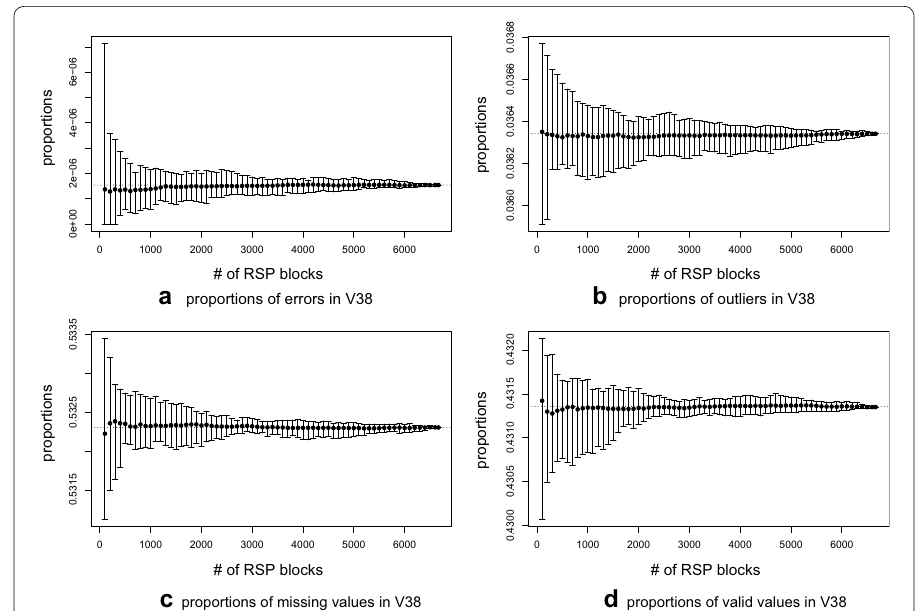
Fig. 11 Proportions of V38. Incremental estimation of proportions in V38 using samples of RSP blocks of Power data ( g = 100